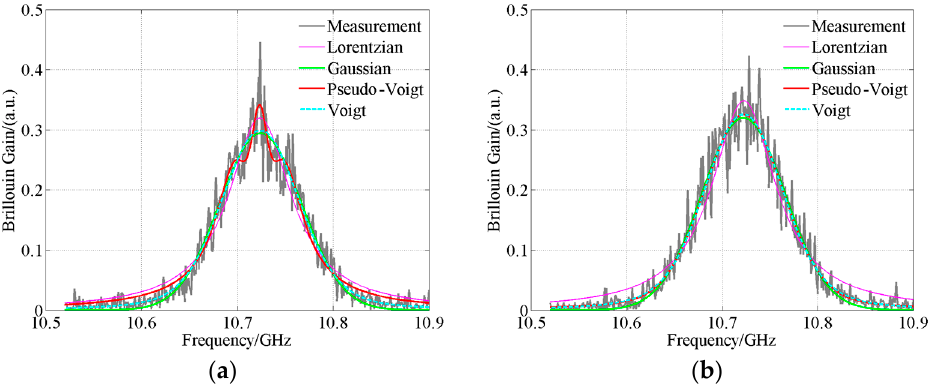
Figure 8. Waveshapes fitted by different models, measured signals with average number of 2 10 . ( a ) Pseudo-Voigt model converges to an erroneous solution; ( b ) Pseudo-Voigt model converges to a correct solution. Table 8. Statistical results of g BM , v B , Δ v B , E and T extracted by different models, measured signals with average number of 2 10 .